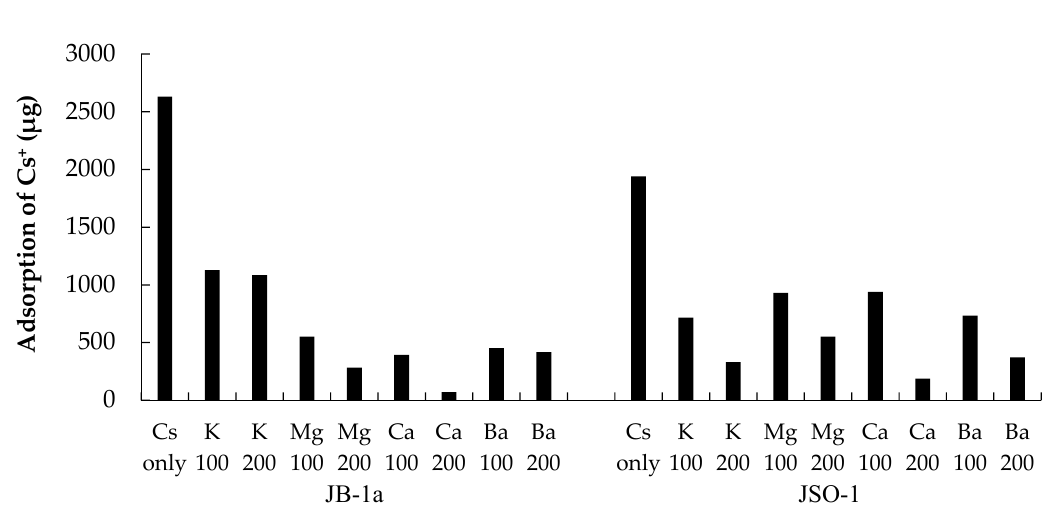
Figure 4. Adsorption quantity for Cs + in solutions with coexisting ions: K + , Mg 2+ , Ca 2+ , and Ba 2+ . The initial concentration of each coexisting ion was 100 or 200 mg/L.